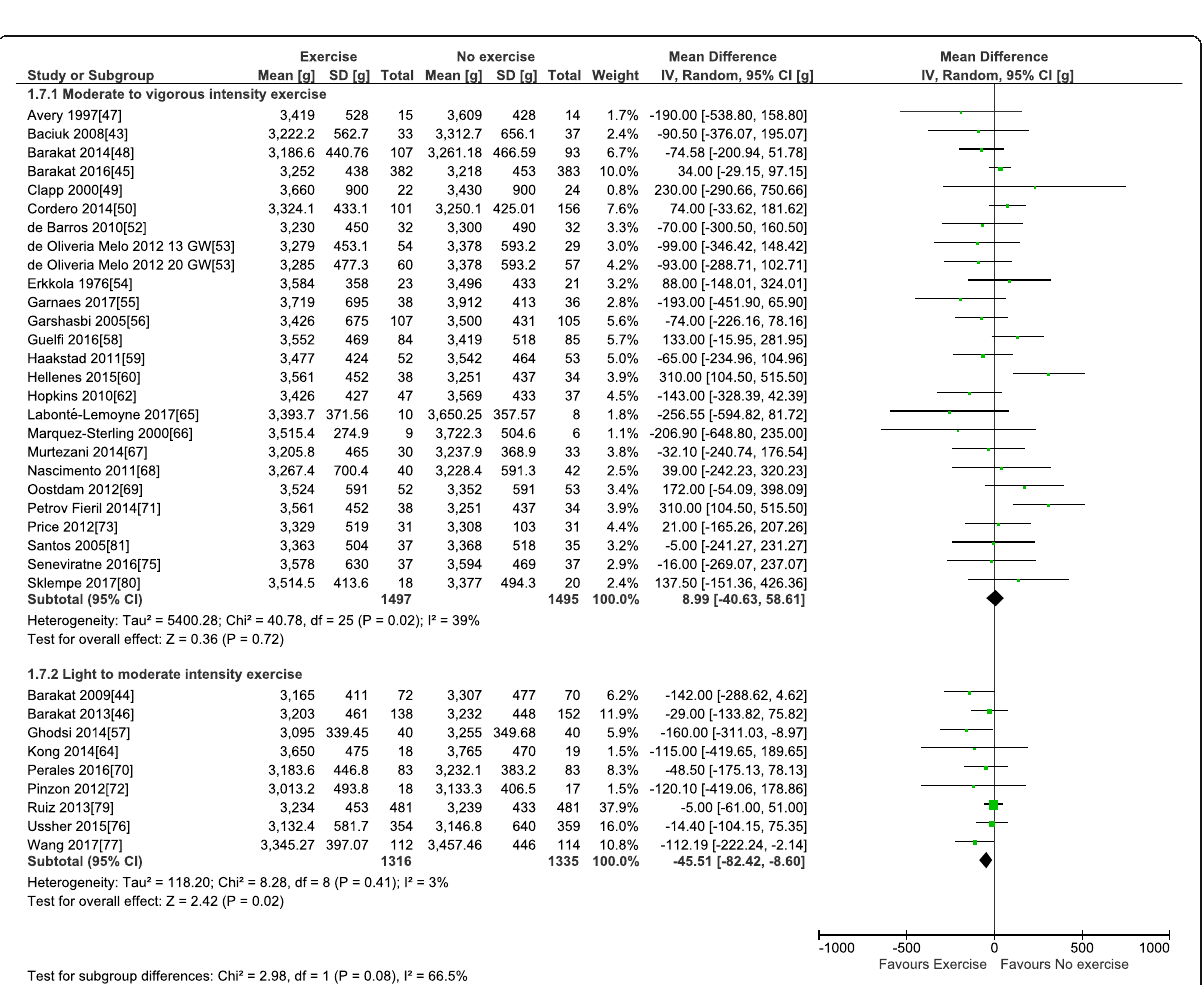
Fig. 6 Forest plot of pooled mean differences for birthweight after exposure to prenatal exercise vs. no exercise; sub-grouping by intensity level : Moderate to vigorous and Light to